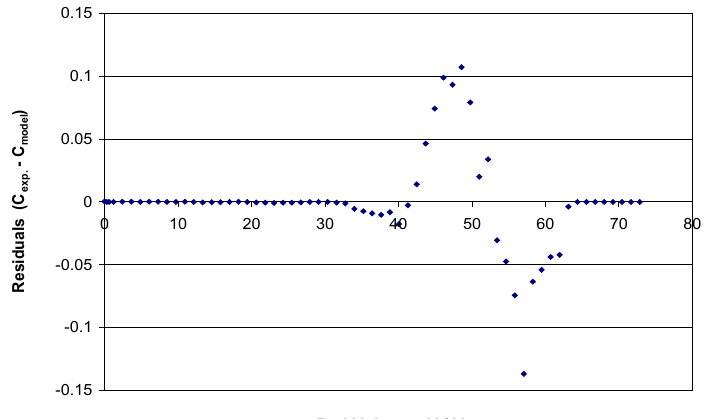
Fig. 8. Residuals of experimental and the Mass Transfer Model calculated uranium breakthrough curve.